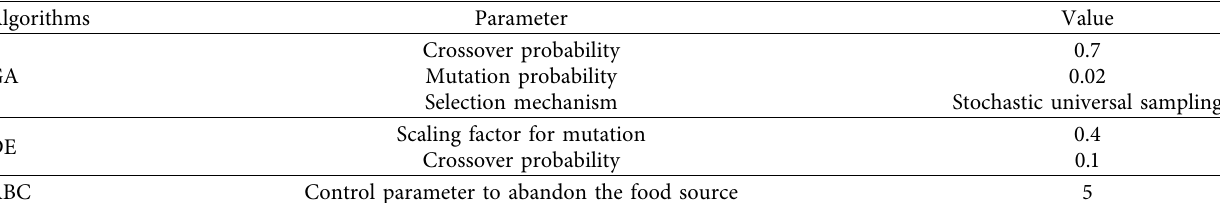
Table 2: Initial parameters of the meta-heuristic algorithms.